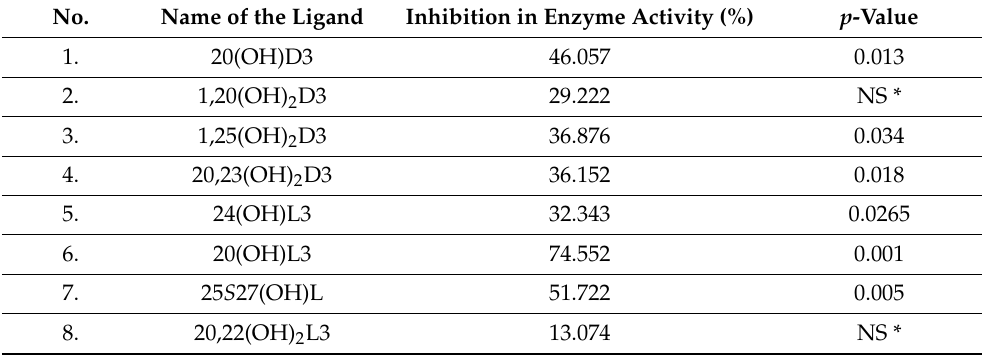
Table 1. Inhibition of ACE2 and RBD interaction by the hydroxymetabolites. Inhibition by the selected from Acro Biosytems. The assay followed the manufacture’s protocol of the SARS-CoV-2 (B.1.617.2) Inhibitor Screening Kit (Spike RBD) (1 Innovation Way, Newark, DE 19711, USA). Data were analyzed by one way ANOVA using GraphPad Prism statistical